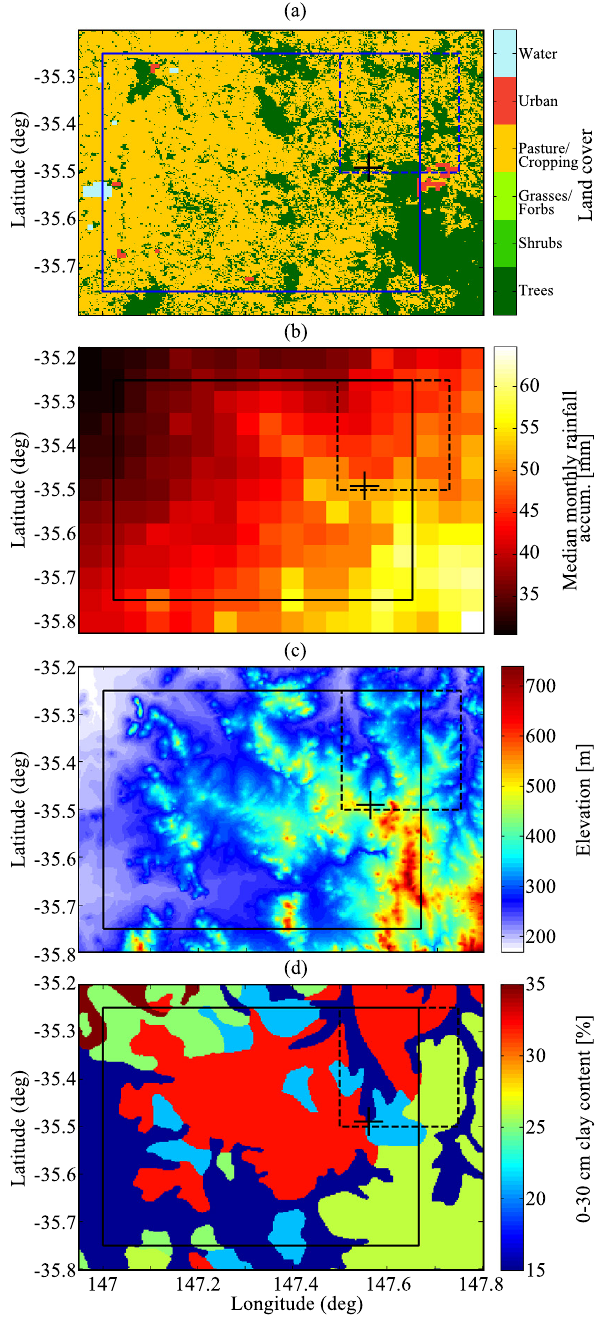
Figure 1. Spatial variability of land surface and rainfall over Kyeamba Creek. The cross denotes the location of the K1 moni- toring station, and the dashed (solid) box is the pixel area of AMS